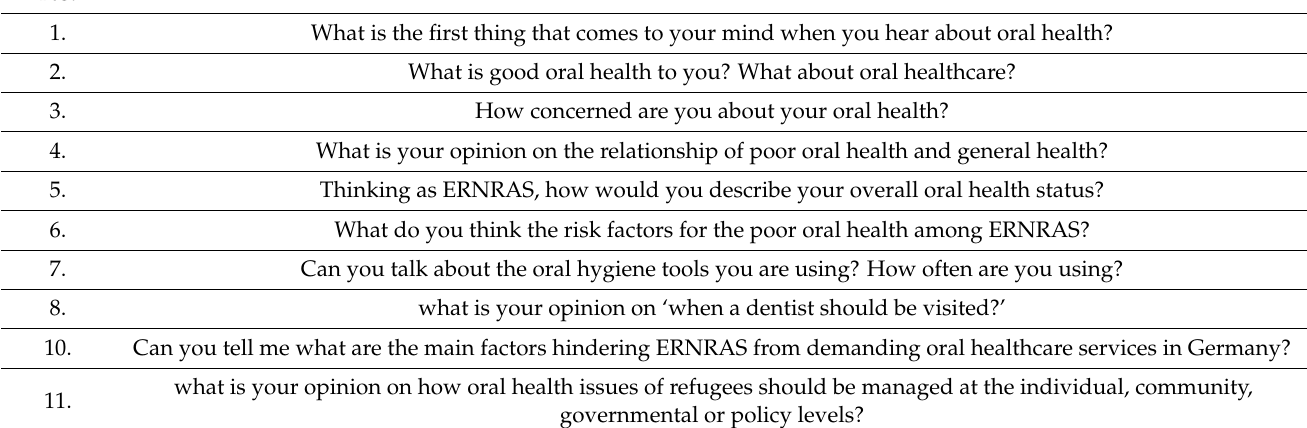
Table A1. Wide-ranging questions of the IDI and